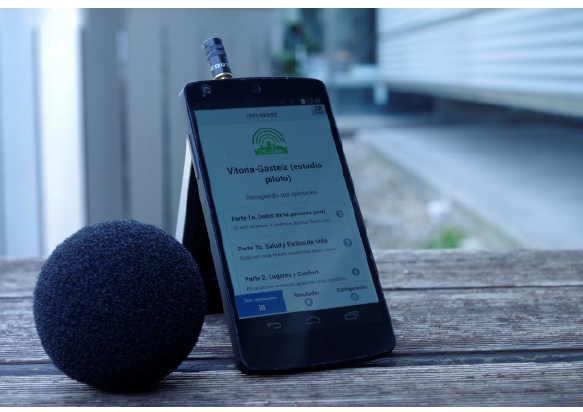
Figure 1: The CITI SENSE kit for the observations.